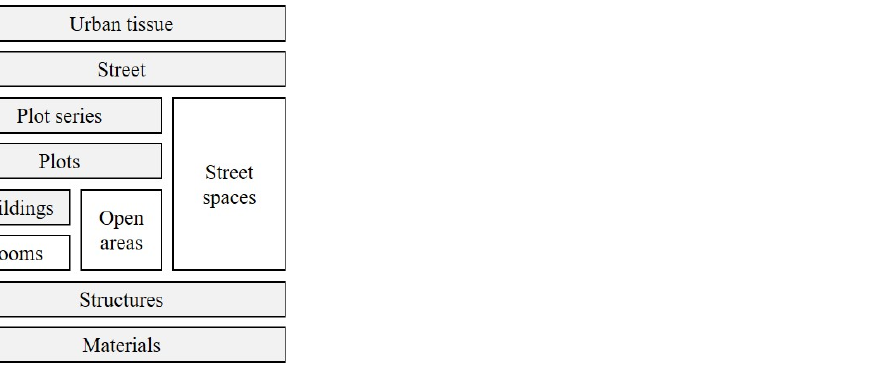
Figure 1. Klopf’s generic structure (refer to The Handbook of Urban Morphology [13] for